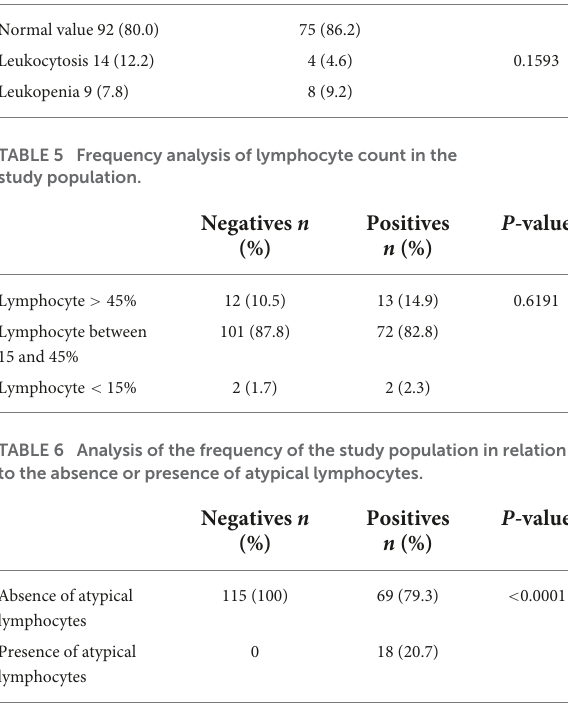
TABLE 4 Analysis of the number of leukocytes in cases with and without the human T-lymphotropic virus type 1 (HTLV-1) infection. Negatives n (%) Positives n (%) P -value Normal value 92 (80.0)